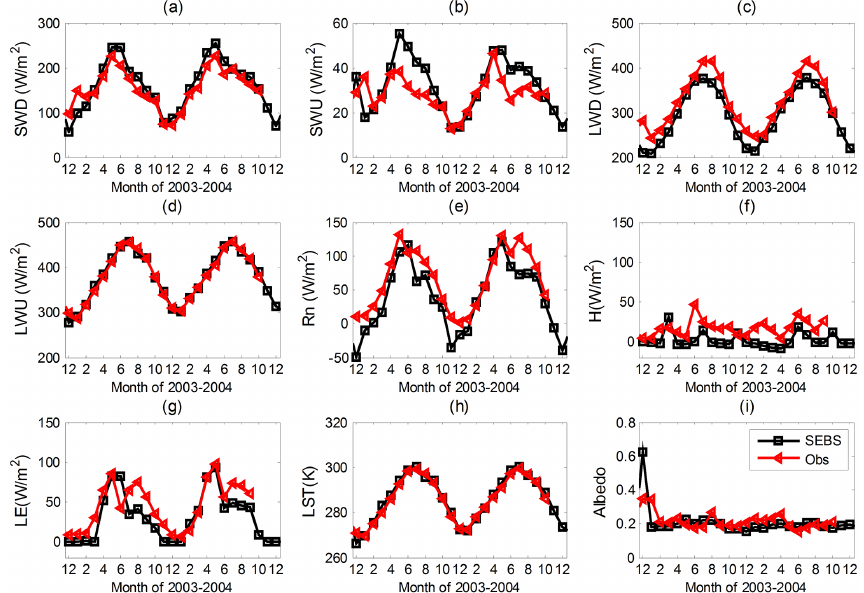
Figure 5. Time-series comparison of SEBS input and output variables against measurements at Yucheng station. Black lines are SEBS results; red lines are measured